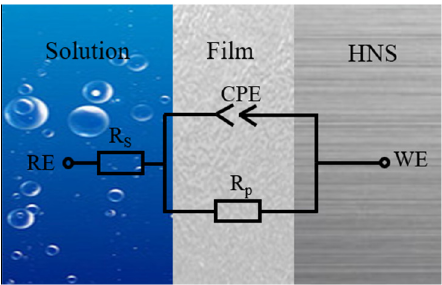
Figure 7. The equivalent circuit used for quantitative evaluation of the EIS. (RE is reference electrode, R s is the solution resistance, R p is the resistance of the passive film, CPE is the constant phase element and WE is working electrode). Table 2 lists R ct values for the two materials. R s and R p values increase after solution treat- tive passive film with better corrosion resistance. Table 2. EIS fitted results for HNS and ST. Samples